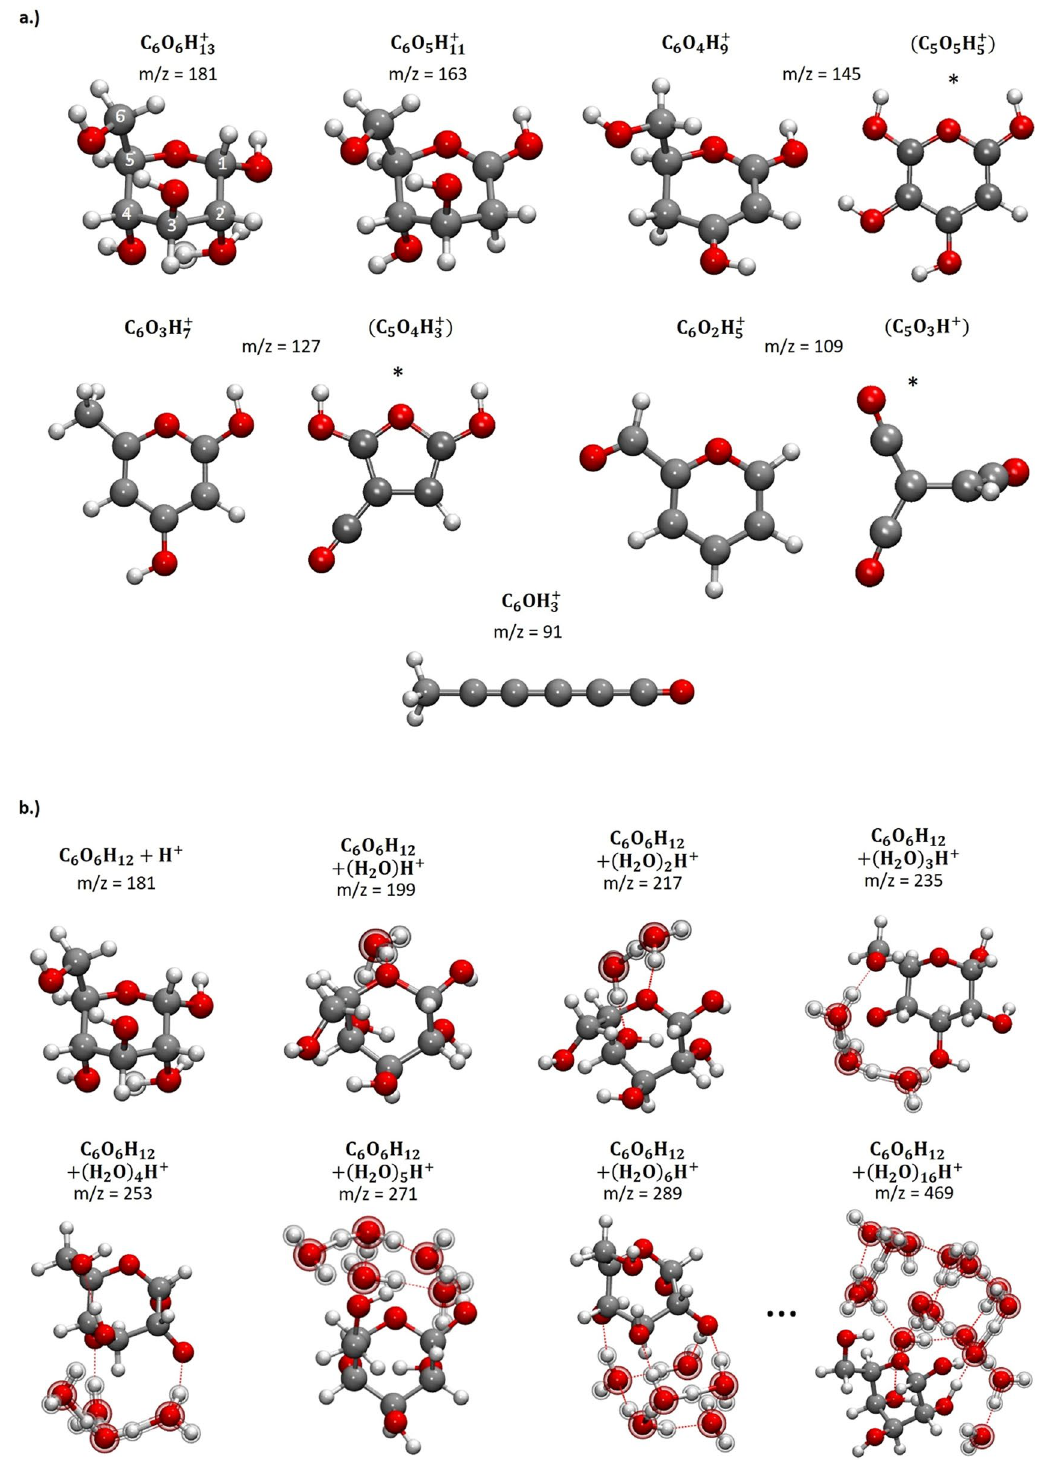
Figure 4. ( a ) Molecular structures corresponding to the mass-to-charge state ratios of m/z = 181–n∙18 u with n = 0 to 5 until m/z = 91 u. All structures shown here represent the isomers with the lowest energy. Alternative molecules at m/z = 145, 127 and 109 u are marked with (*). However, they are deemed unlikely, because they would require the simultaneous removal of one carbon along with several H atoms. ( b ) Molecular clusters formed by adding cations to glucose: left to right: glucose molecule (α-D-glucopyranose) with addition of H + , H 3 O + and H 5 O 2+ until (H 2 O) 6 H + , which form water clusters bound to glucose via hydrogen bonds (dotted lines). The structure shown for C 6 O 6 H 12 + (H 2 O) 16 H + is the result of an MD simulation with GFN-xTB, followed by an energy minimization with BP86/def2-SVP. It is obvious that the glucose molecule locates on the surface of a water cluster. The additional atoms are emphasized by depicting them in a different